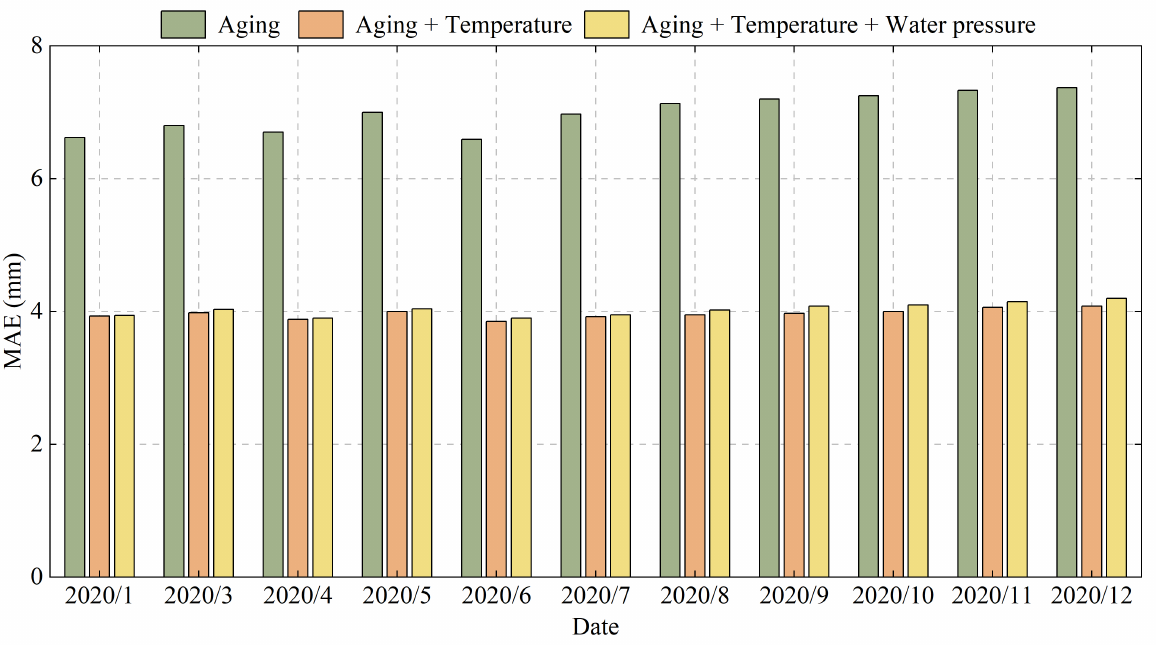
Figure 5. Results of the variable importance for projection of vertical deformation.